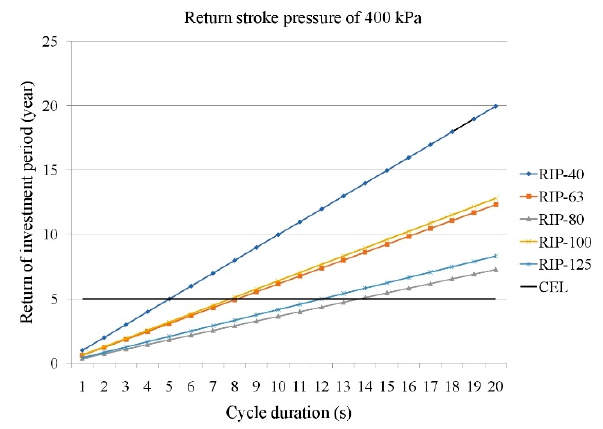
Figure 7. Return of investment period (RIP) with return stroke pressure of 400 kPa.